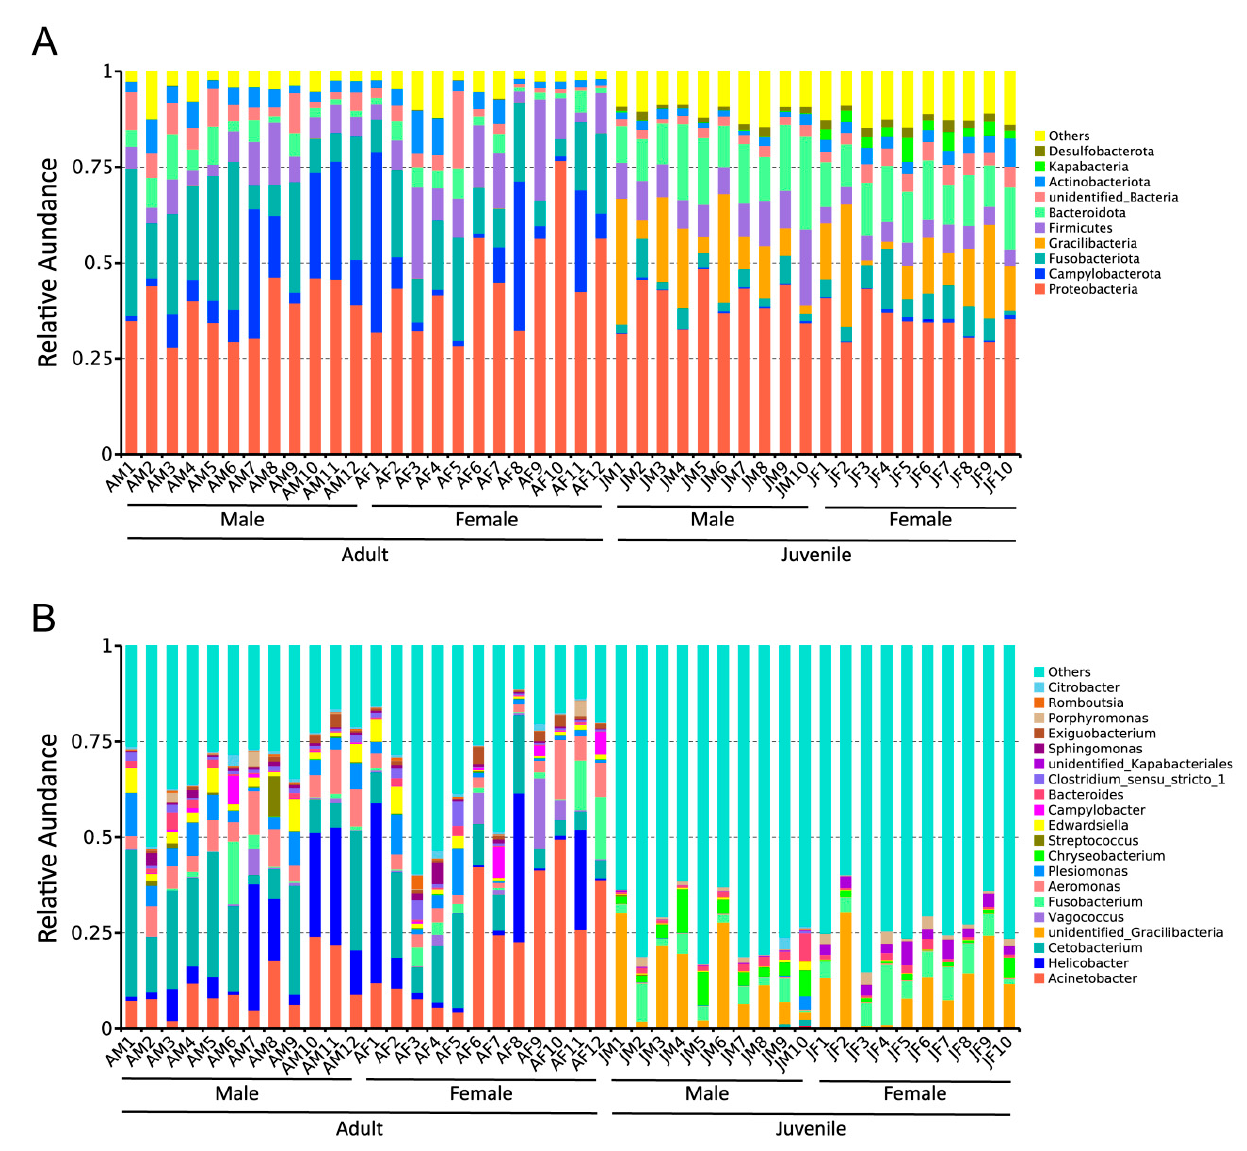
Figure 1. Relative abundance of the top 10 most abundant bacterial phyla ( A ) and the top 20 most abundant bacterial genera ( B ) in each sample. AM: adult male, AF: adult female, JM: juvenile male, JF: juvenile female.